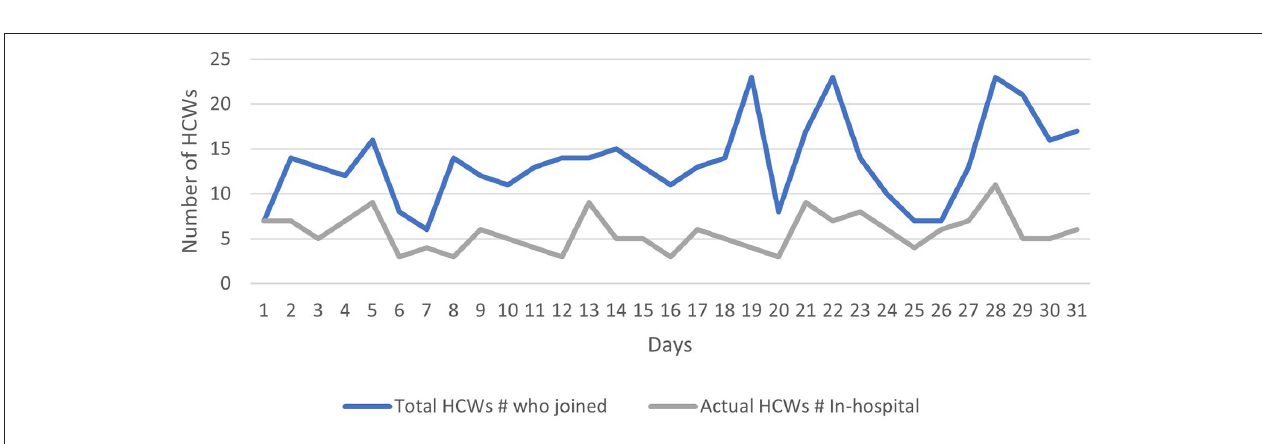
FIGURE 2 | Total number HCWs who joined both the Zoom and the physical (in-hospital) part of hybrid rounds per day.